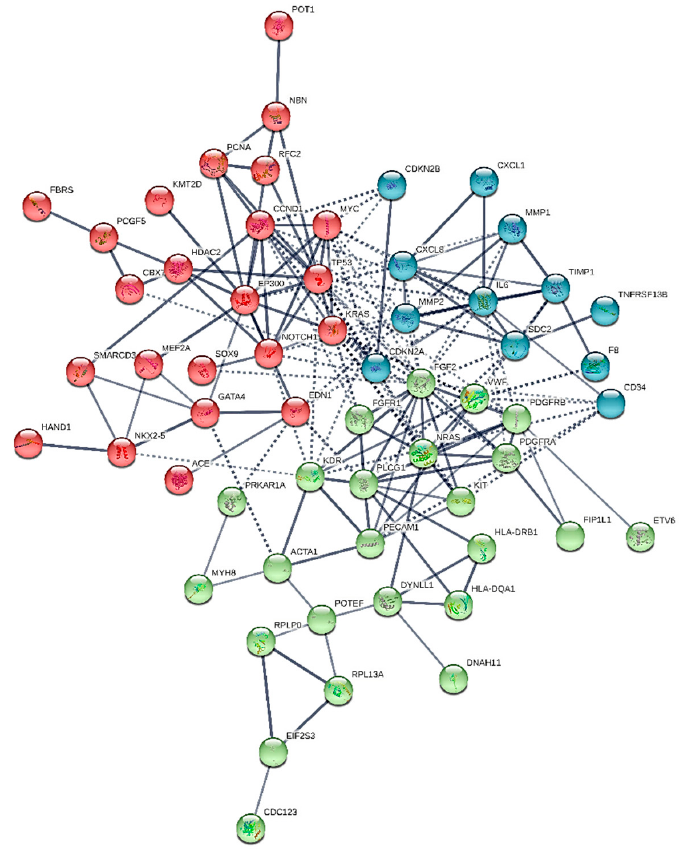
Figure 1. The heart angiosarcoma interactome.